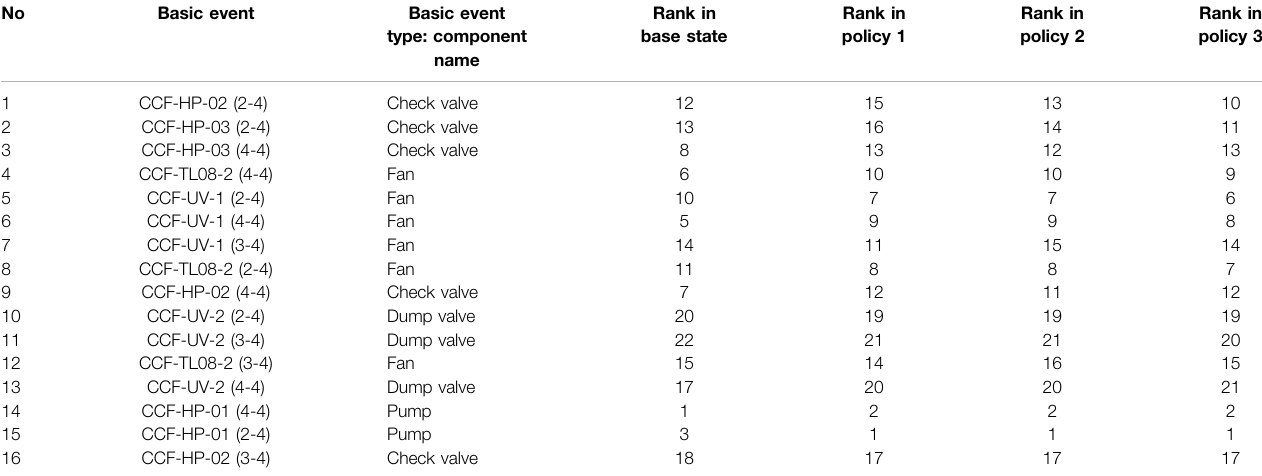
TABLE 10 | Ranking alteration of the basic evens related to “ F ” function of ECCS with changing different policies obtained by importance analysis. No Basic event Basic event type: component